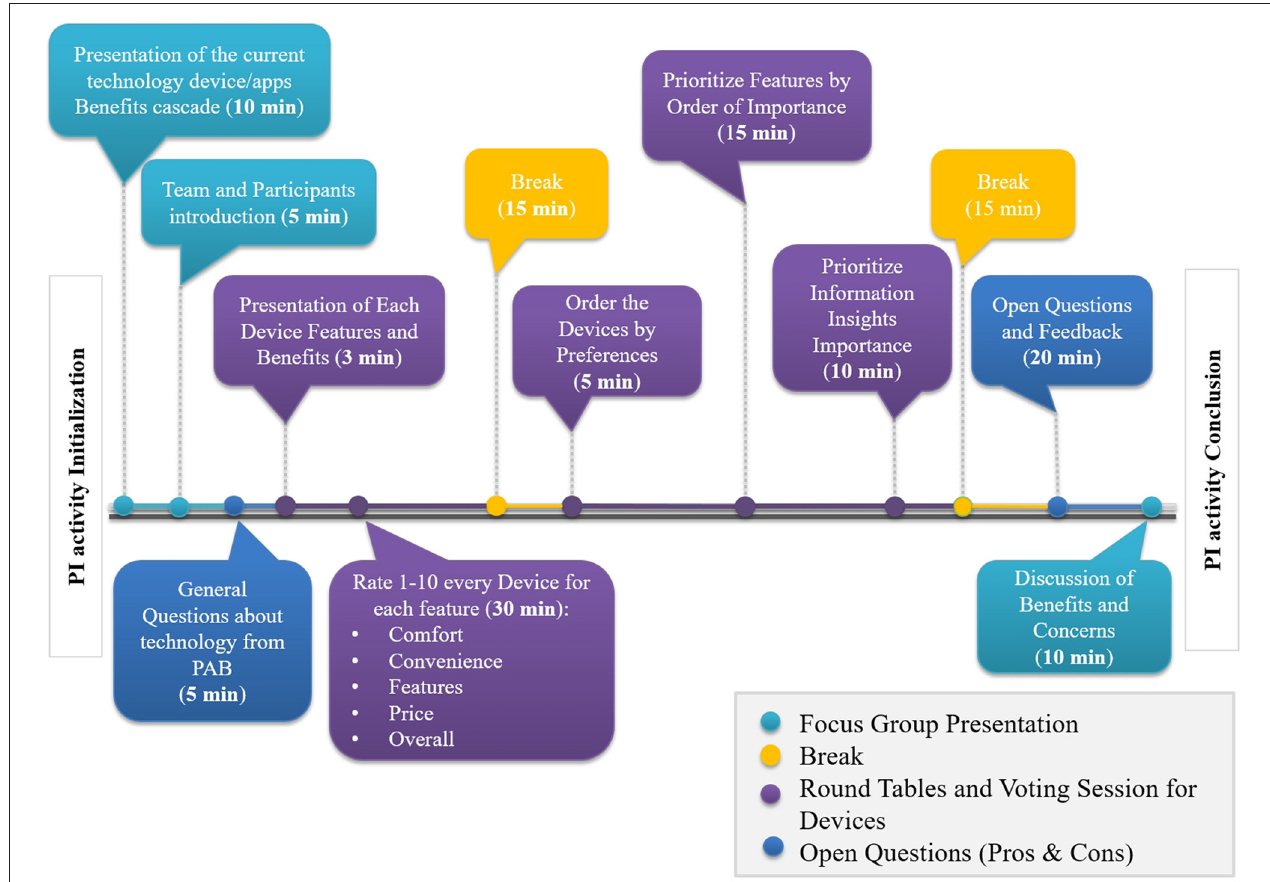
FIGURE 2 | Focus Group process